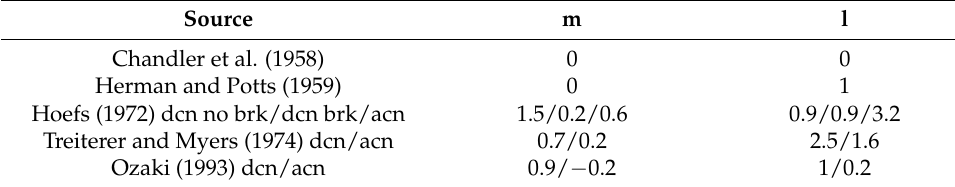
Table 1. Estimation of GHR model parameters (adapted from Brackstone & McDonald [4]).